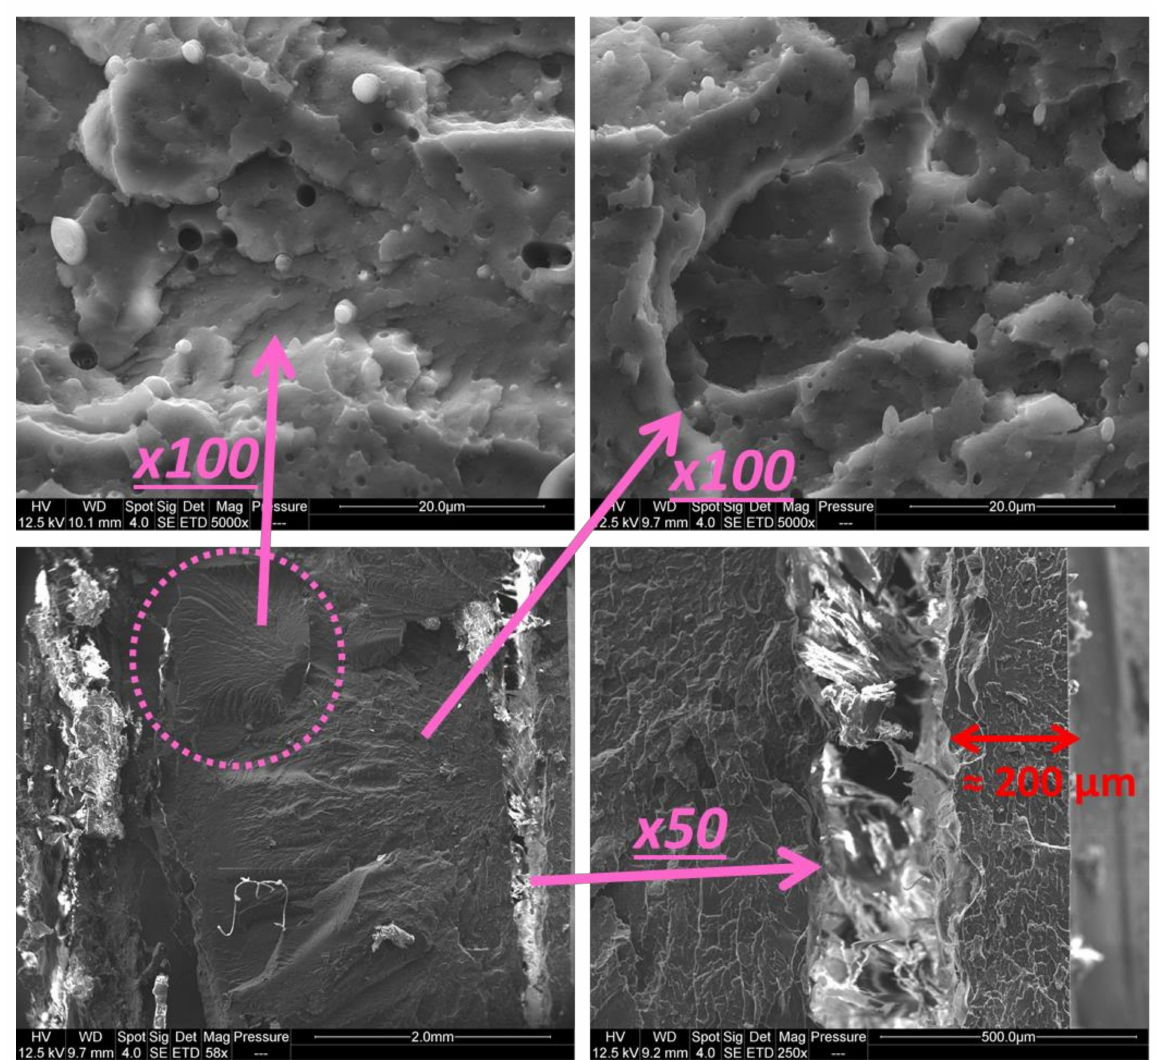
Figure 8. SEM pictures of cryofractured 8 wt% PP contaminated ABS dogbone—magnified views of different